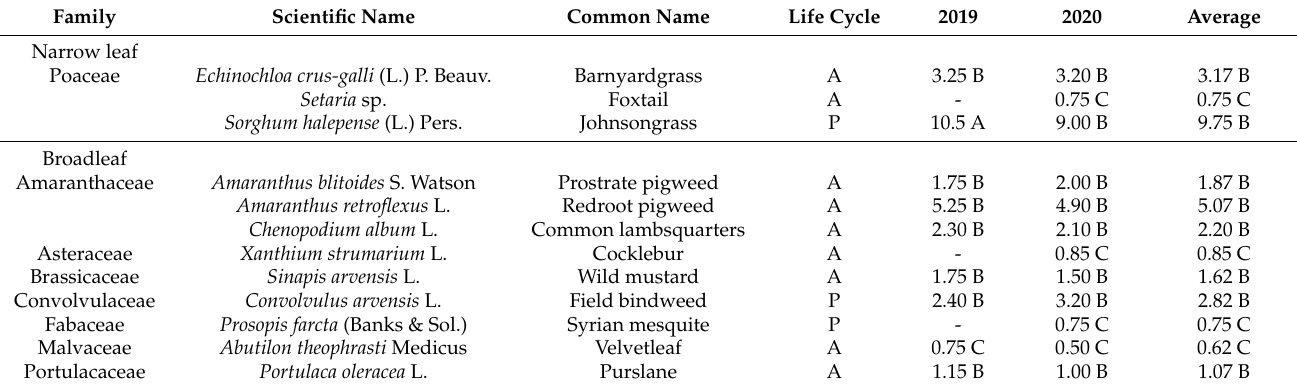
Table 5. Weed species, families, scientific names, common names, life cycles, and average densities (number/m 2 ) and density level (grade) in the experimental area in both years